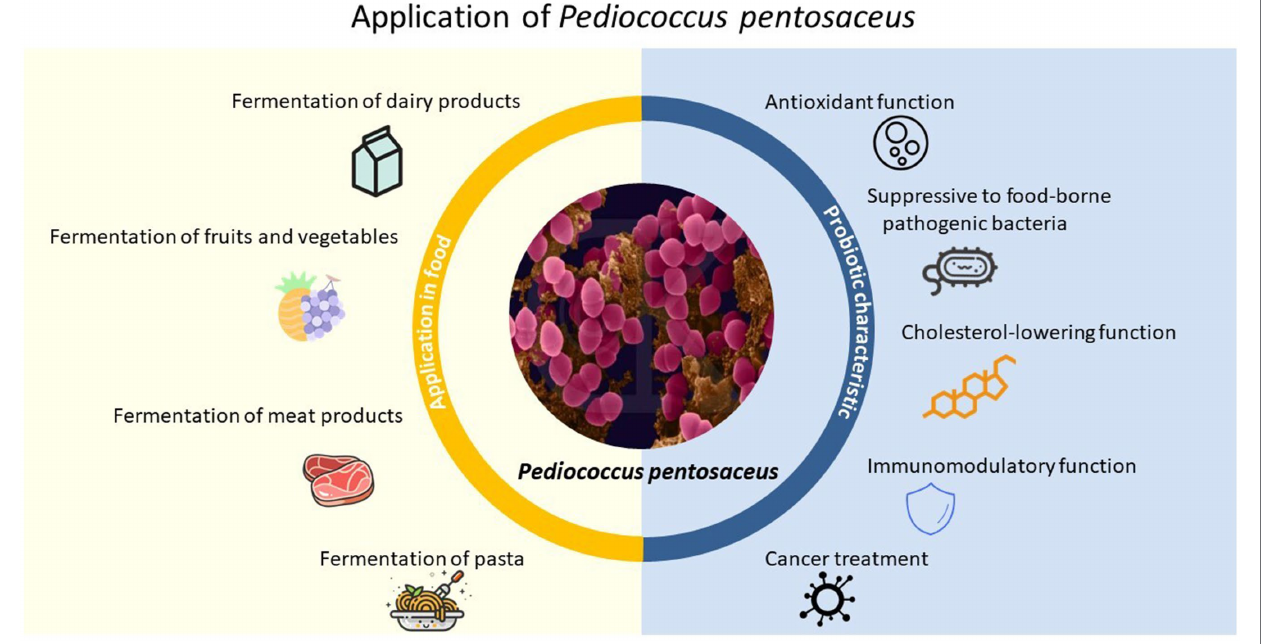
FIGURE 1 | Application of P. pentosaceus in food processing and probiotic